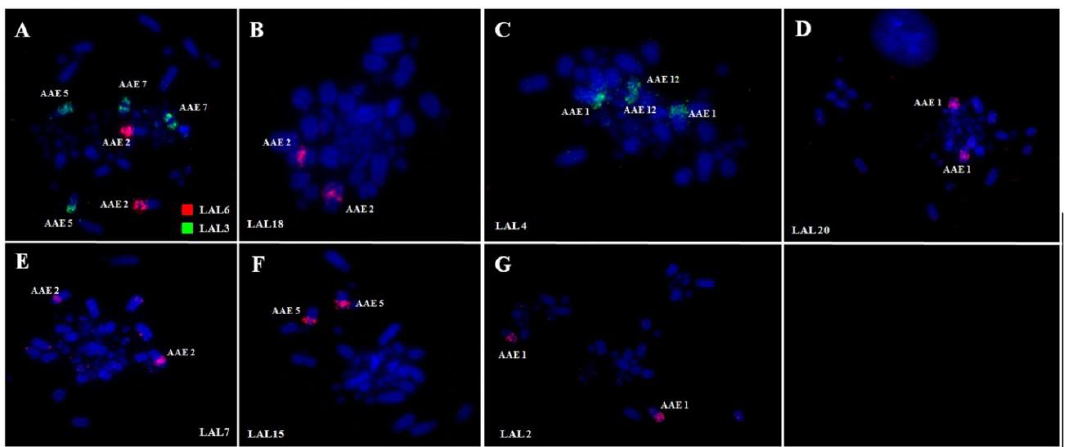
Figure 6. Fluorescent in situ hybridization with whole-chromosome probes of L. albicollis in metaphases of A . aestiva .